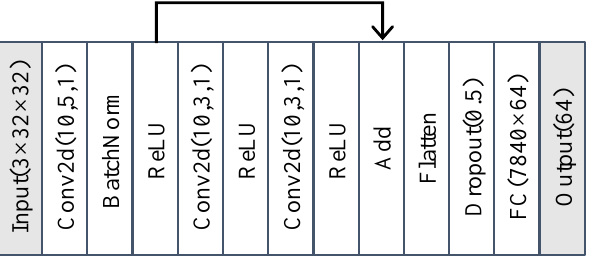
Figure 9. The architecture of the feature extractor for the real ADS–B